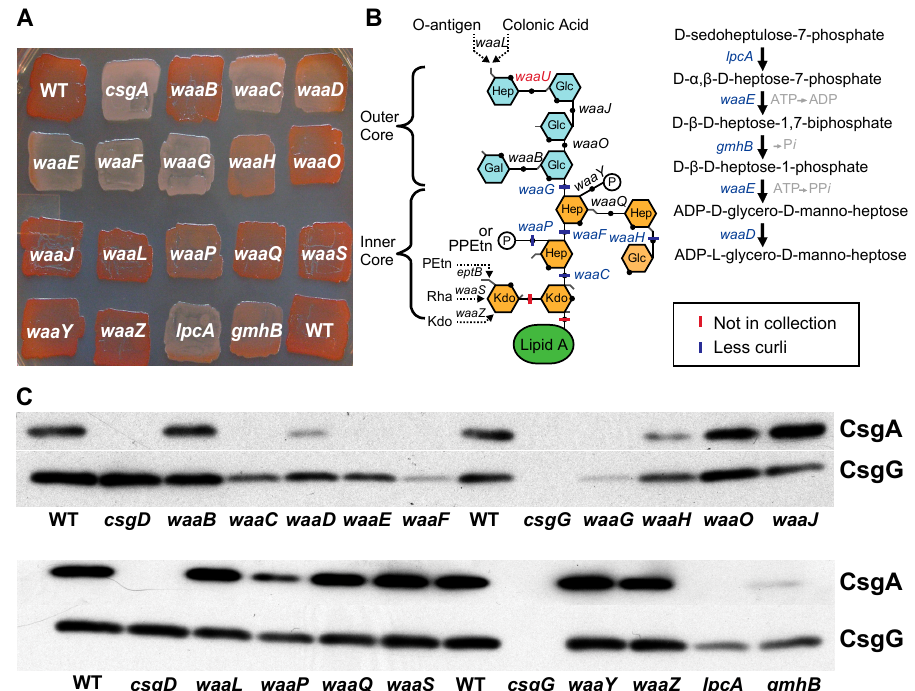
Figure 3. Lipopolysaccharide (LPS) mutants are defective for curli production. ( A ) LPS mutant strains and BW25113 (WT) grown on CR indicator plates at 26 ◦ C for two days. ( B ) A schematic of LPS structure. Blue lines represent curli defective LPS mutants. Red lines represent LPS genes not in the Keio collection. ( C ) Whole cell Western blots of LPS mutants probed with anti-CsgG and anti-CsgA antibodies. All samples were grown on YESCA plates at 26 ◦ C for two days and treated with formic acid.